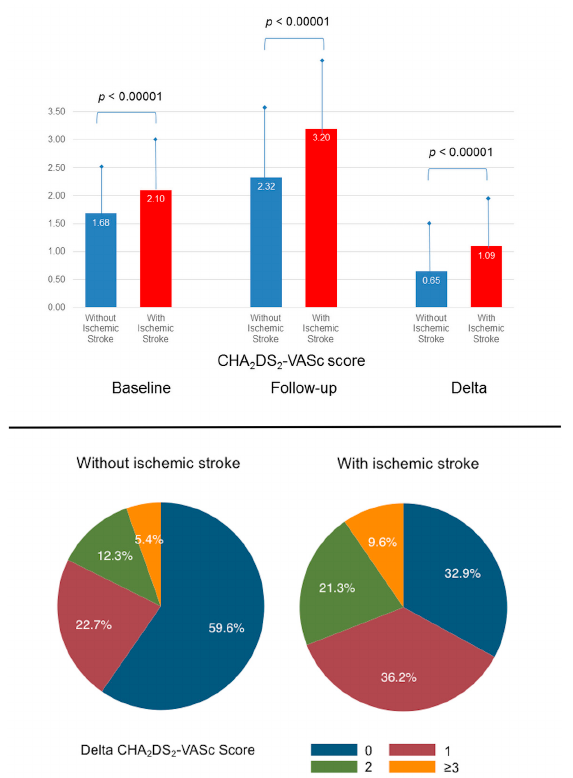
Figure 2. CHA 2 DS 2 -VASc scores of patients with AF with or without ischemic stroke: baseline, follow-up, and Delta CHA 2 DS 2 -VASc scores (top panel) and repartition of Delta CHA 2 DS 2 -VASc in these patients (lower panel). CHA 2 DS 2 -VASc score: (congestive heart failure, hypertension, age ≥ 75 years (doubled), diabetes, stroke / transient ischemic attack / thromboembolism (doubled), vascular disease (prior myocardial infarction, peripheral artery disease, or aortic plaque), age 65–75 years, sex category (female)).